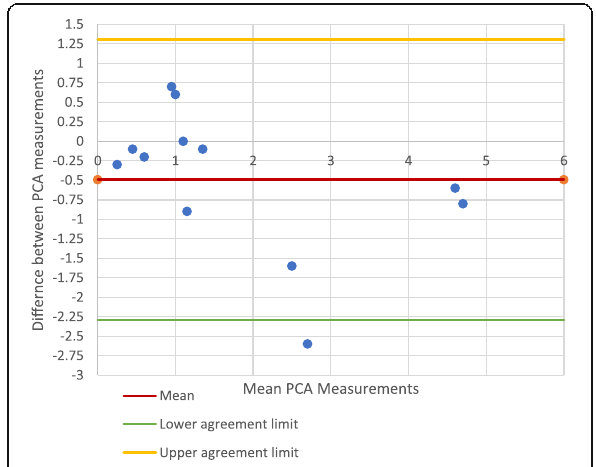
Fig. 8 PCA Measurements on Mechanical axis CT scanning - Best fit vs Multl-slice